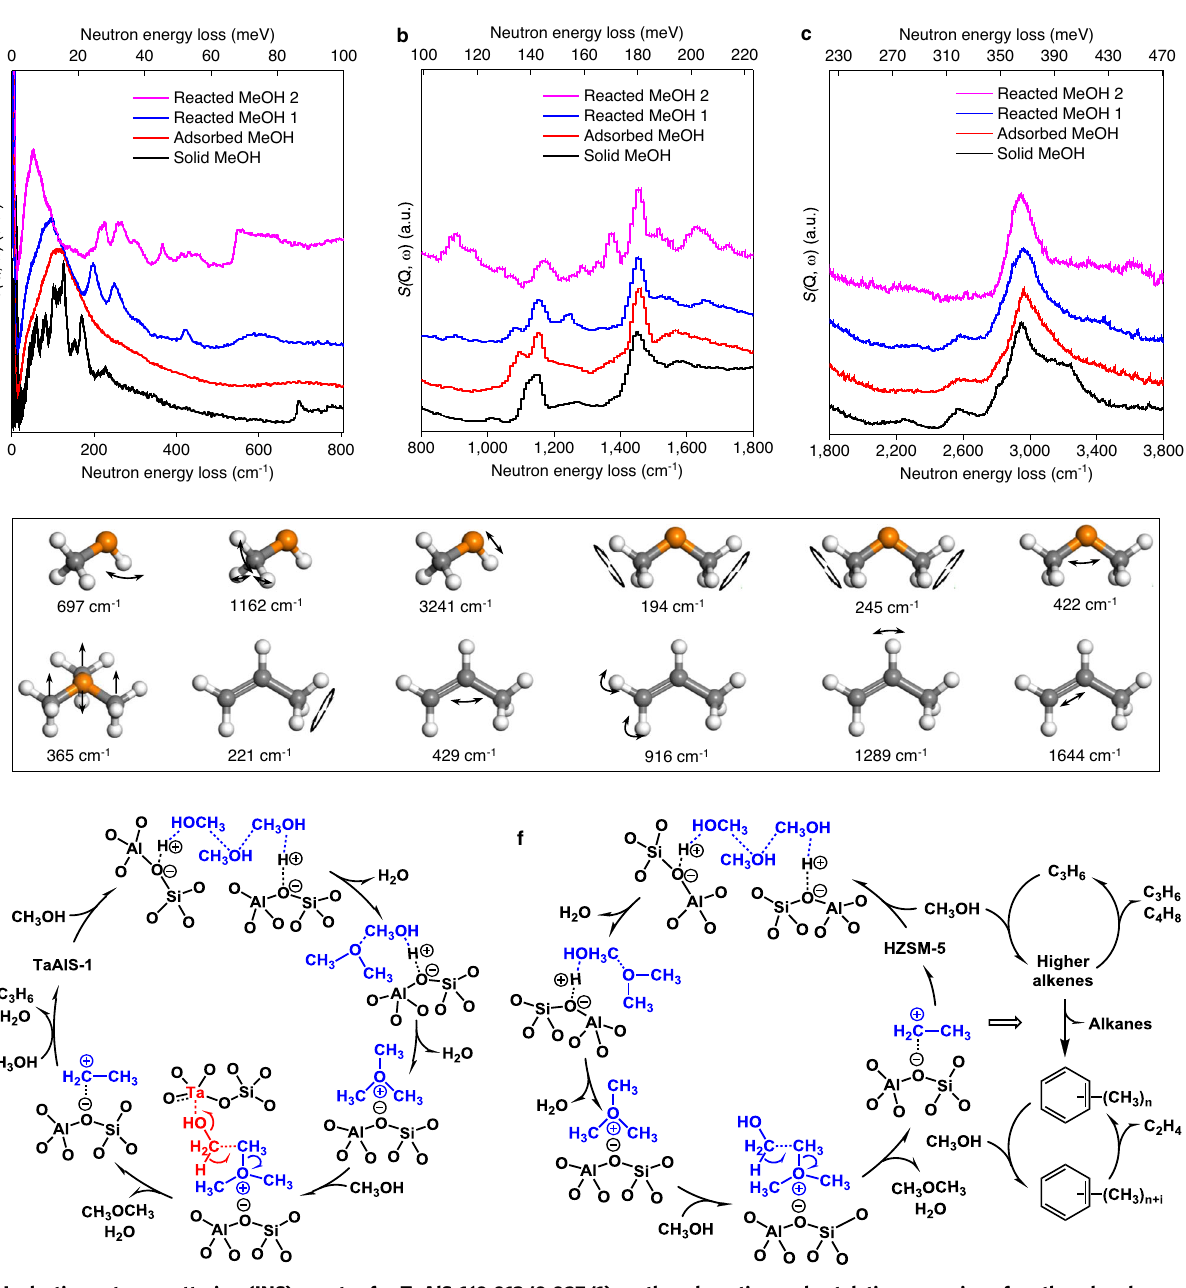
Fig. 5 Inelastic neutron scattering (INS) spectra for TaAlS-1(0.013/0.027/1) on the adsorption and catalytic conversion of methanol and proposed reaction mechanism. All spectra shown here are difference spectra. Full spectra are shown in the SI. The INS spectra of reactant, intermediates and products were recorded and modelled via DFT calculations, allowing a full assignment of the spectral features. Where no error bars are visible these are smaller than the symbols used to represent the data points. Comparison of INS spectra obtained at TOSCA ( a ), at MAPS ( b ) at incident energy 250 meV over the momentum transfer range 0 Å − 1 ≤ Q ≤ 9 Å − 1 and, at MAPS ( c ) at incident energy 650 meV over the momentum transfer range 0 Å − 1 ≤ Q ≤ 9 Å − 1 for condensed solid methanol, adsorbed methanol, and reacted methanol on TaAlS-1(0.013/0.027/1). d Selected vibrational modes of methanol, DME, TMO and propene (C, grey; O, orange; H, white). Proposed reaction mechanism for the conversion of methanol in the induction period over e TaAlS-1 based on INS/SXPD experiments and f in the induction and dual-cycle period over HZSM-5 based on SXPD and literature reports 16,20